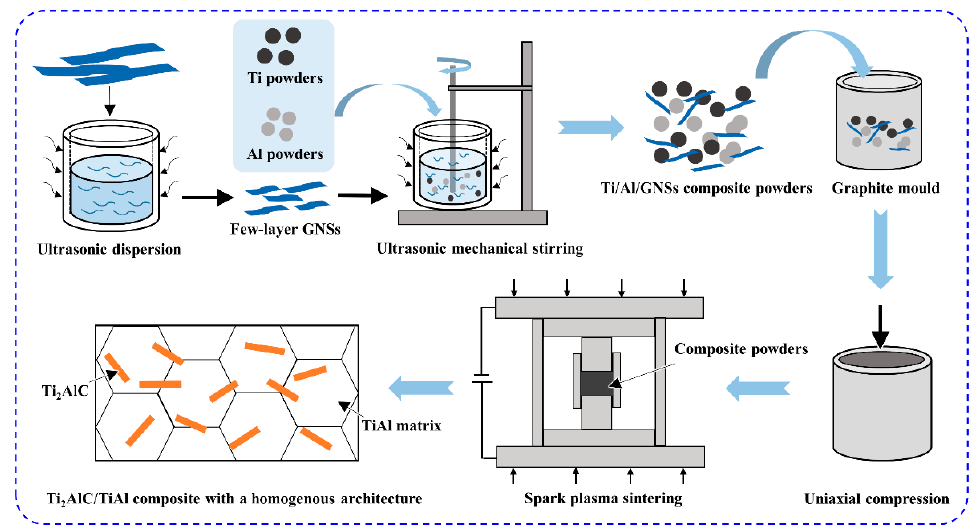
Figure 1. The schematic diagram of fabrication process for Ti 2 AlC/TiAl composite with a homoge- nous architecture.